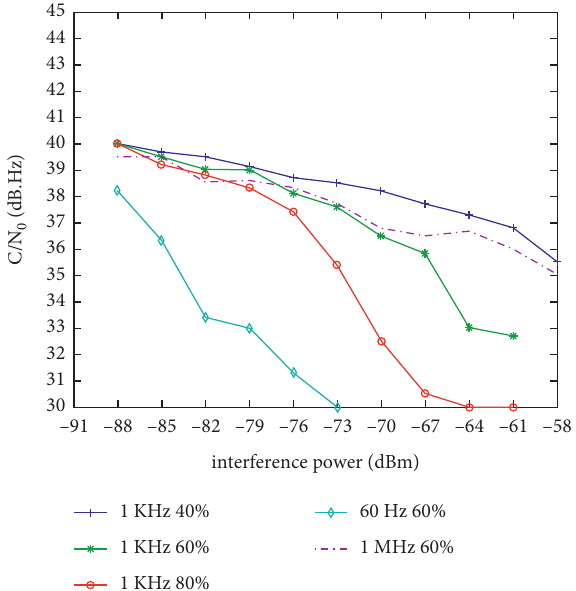
Figure 7: C/N 0 in different pulse parameters (PRN6).